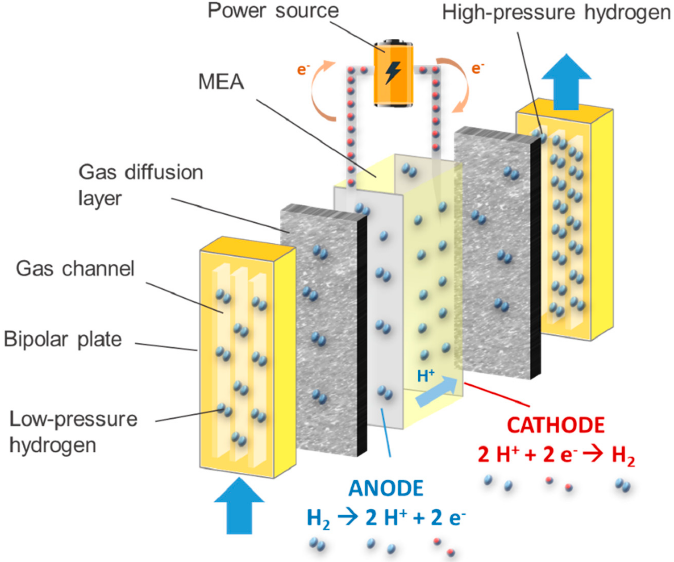
Figure 6. Scheme of the components and reactions taking place in an electrochemical hydrogen compressor.